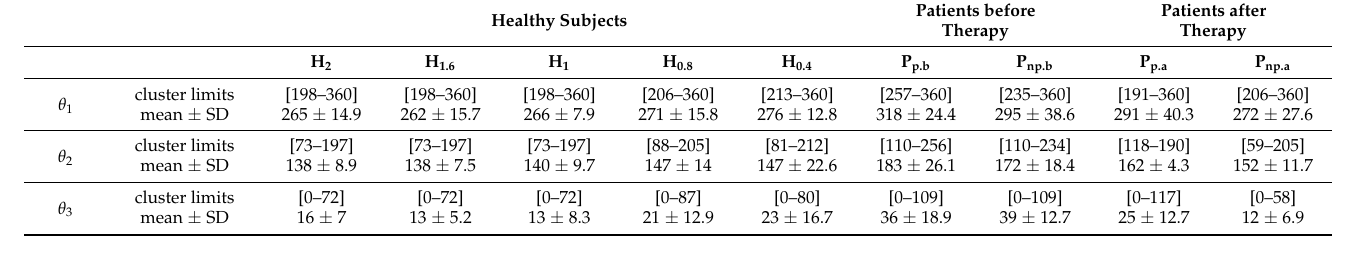
Table 3. Cluster limits (temporal components) in distribution density of angle values θ 1 , θ 2 , and θ 3 , mean ± standard deviation, all expressed in degrees.